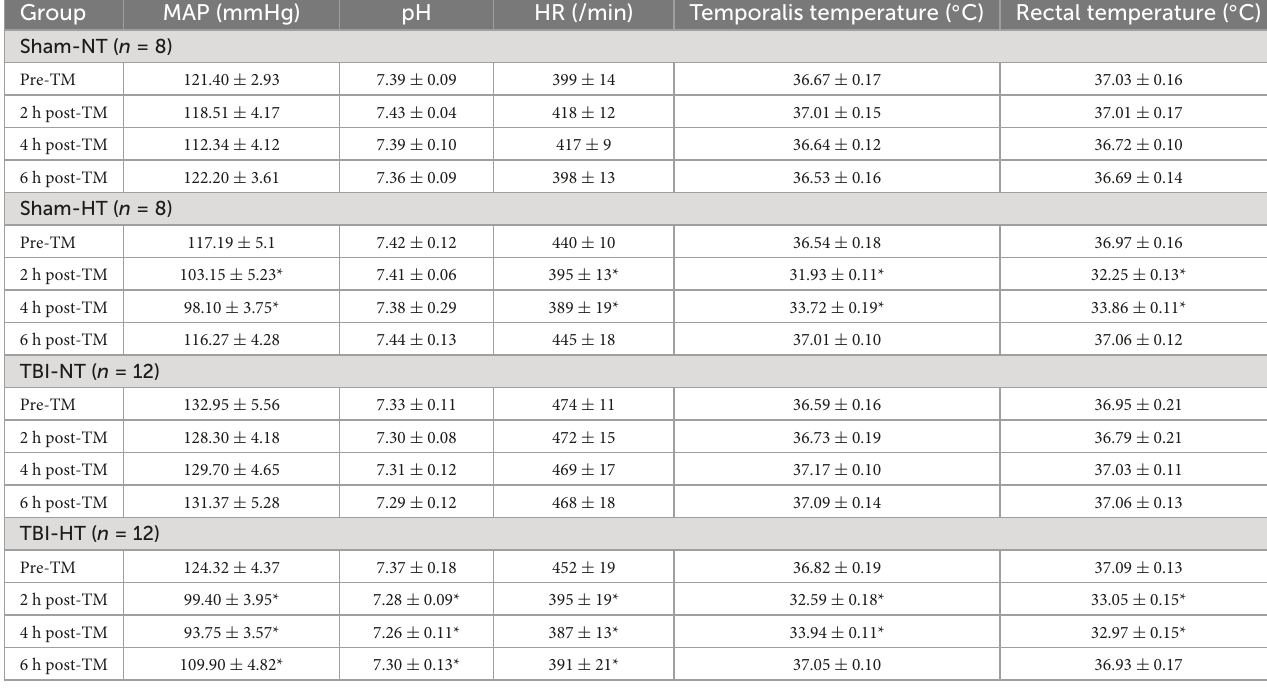
TABLE 1 Physiologic data of the four groups throughout temperature management.